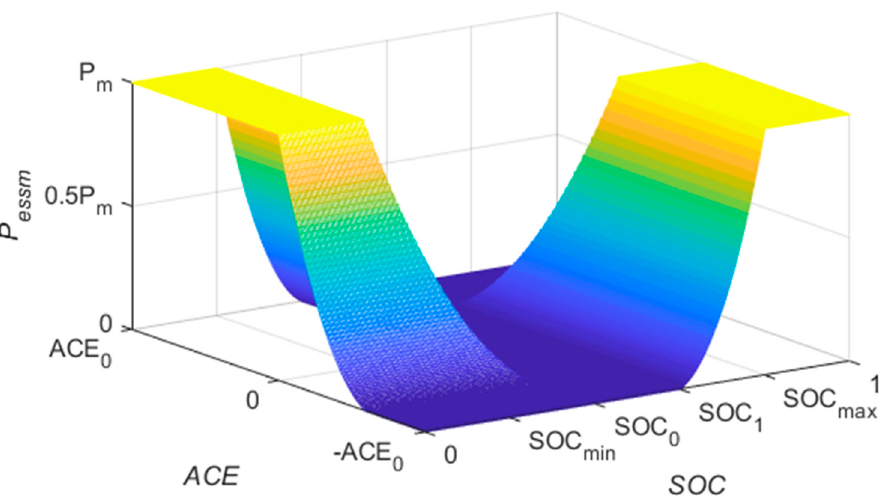
Figure 4. Energy storage battery recovery chart.